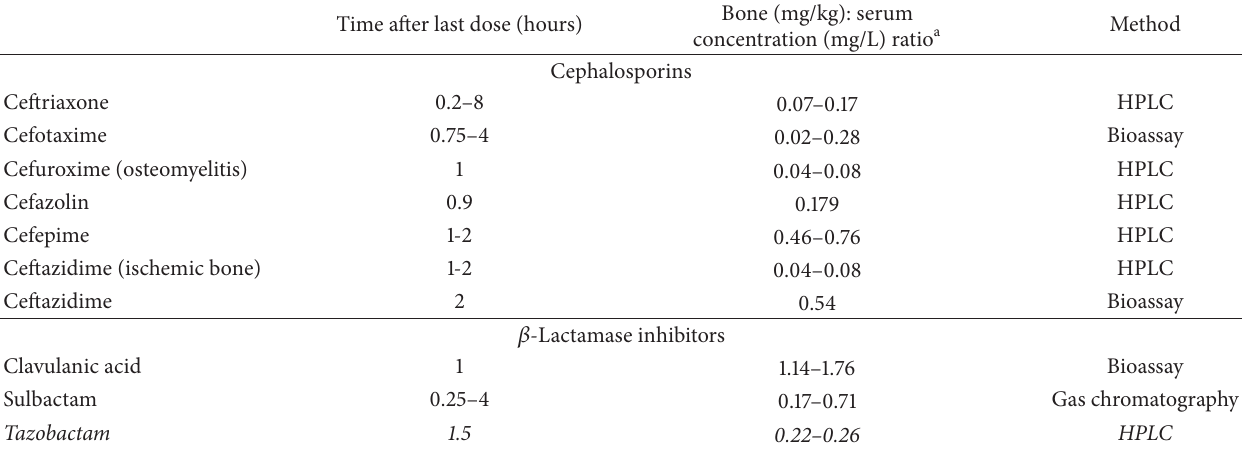
Table 2: Bone penetration of cephalosporins and 𝛽 -lactamase inhibitors [12]. Time after last dose